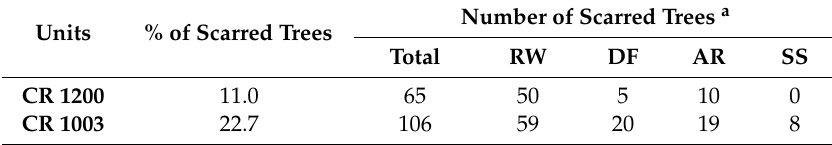
Table 10. Percentage of number of damaged trees based on the landowner’s definition. Units % of Scarred